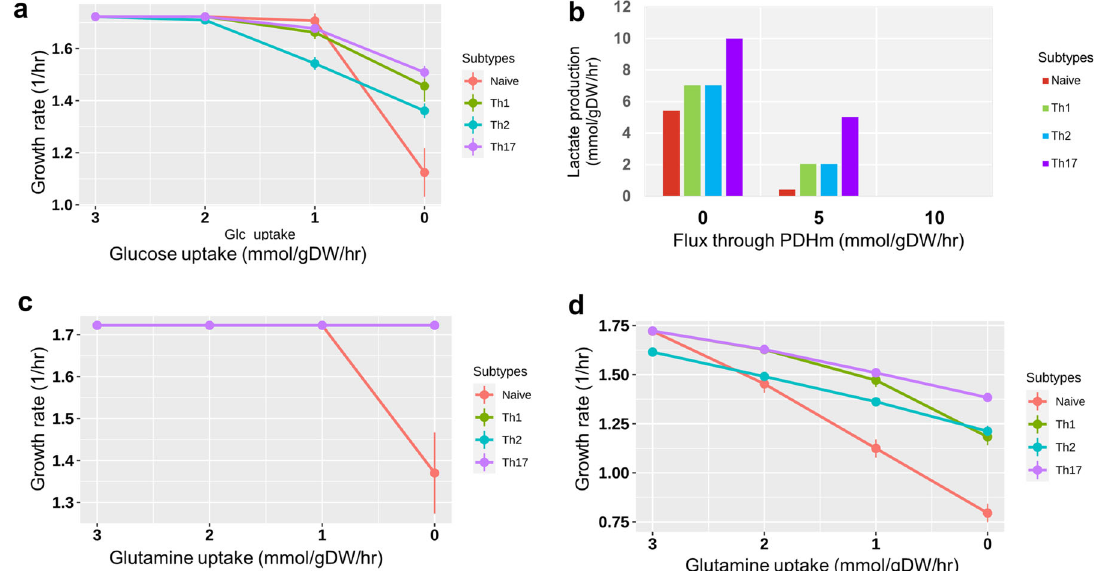
Fig. 4 Model predictions are consistent with the literature. a Dependency of growth rate to varying rate of glucose uptake. b Production of lactate with increased fl ux through pyruvate dehydrogenase. c The dependency of growth rate (in all models) on glutamine when glucose was available (>5 mmol/g DW/hr). d The dependency of growth on glutamine when glucose was removed from the environment. Dots in a , c , and d are average fl ux and error bars are standard deviation ( n = 5). We varied the uptake rate of glucose or glutamine fi ve times ( n = 5) to obtain the average and standard deviation at each dot. For example, in a , the growth rate at 3.0 mmol/g DW/hr glucose uptake is the average of growth rates obtained under 3.2, 3.1, 3.0, 2.9, 2.8 (mmol/g DW/hr) of glucose